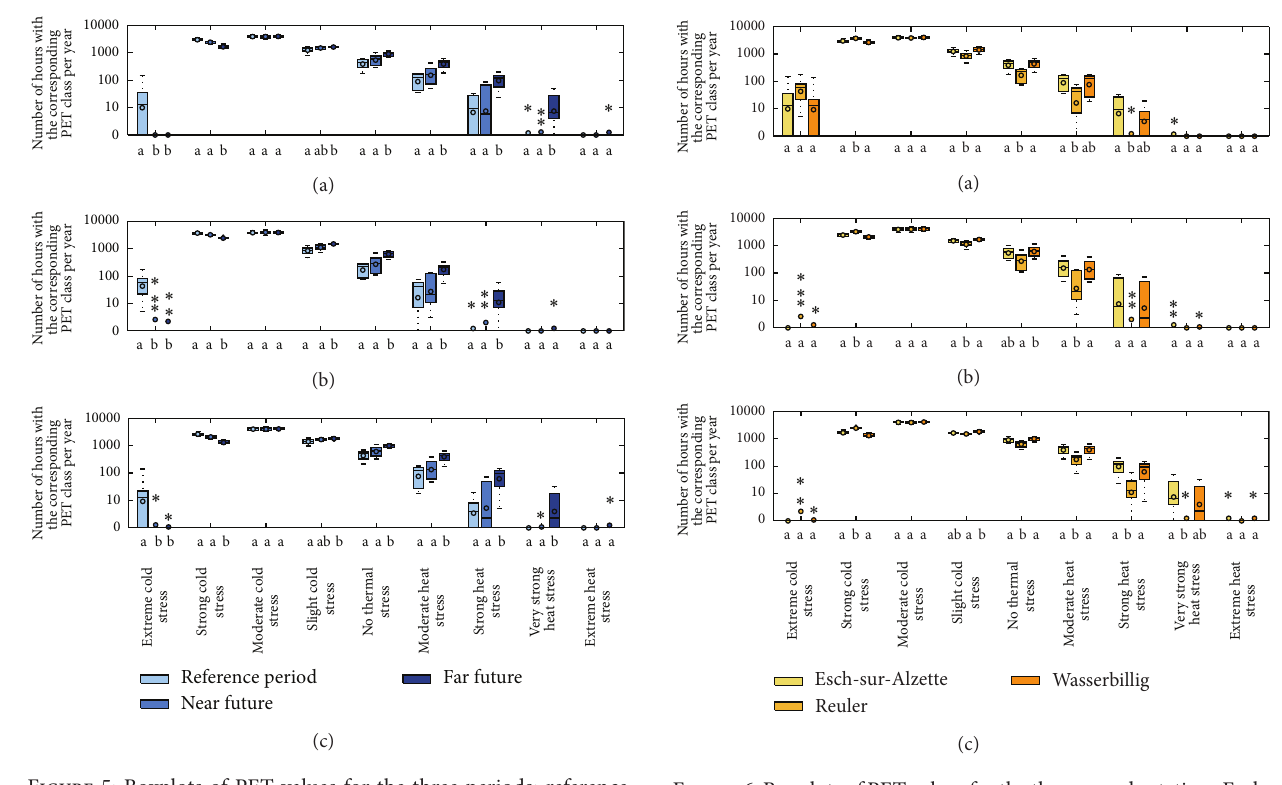
Figure 6: Boxplots of PET values for the three pseudo stations Esch- sur-Alzette, Reuler, and Wasserbillig separated by the three periods: reference period 1991–2000 (a), near future 2041–2050 (b), and far future 2091–2100 (c). Boxplots show the number of hours within the corresponding PET class per year. The whisker length is determined by1.5 ∗ interquartilerange(IQR).Allvalueslargerthan1.5 ∗ IQRare treated as outliers. Median values are indicated by the line inside the box; mean values are highlighted by the dot. Groups that are